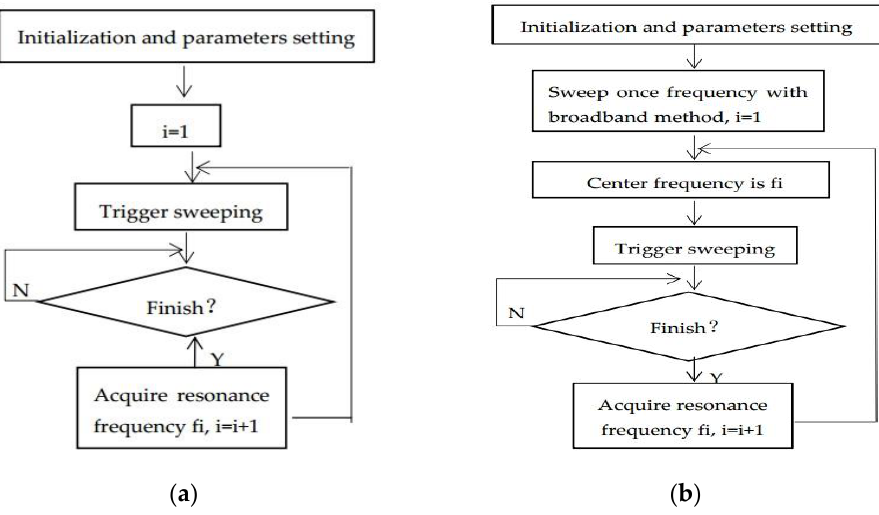
f : ( a ) the broadband method and ( b ) the narrow band Figure 3. Two methods of measuring Figure 3. Two methods of measuring f 0 : ( a ) the broadband method and ( b ) the narrow band 0 method.